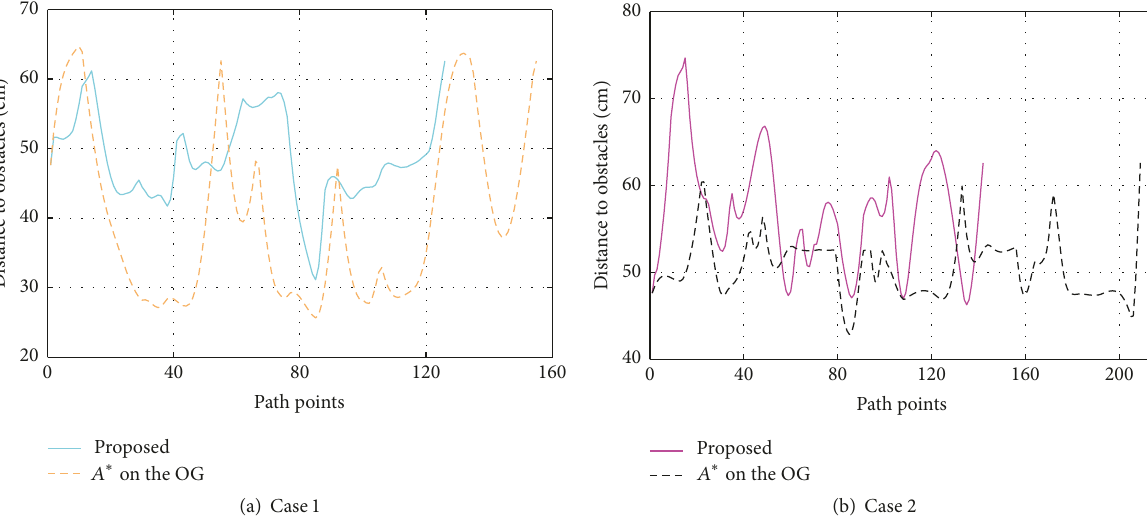
Figure 7: Evolution of the distance to obstacles ((a) 𝛿 = 20 cm, (b) 𝛿 = 40 cm).